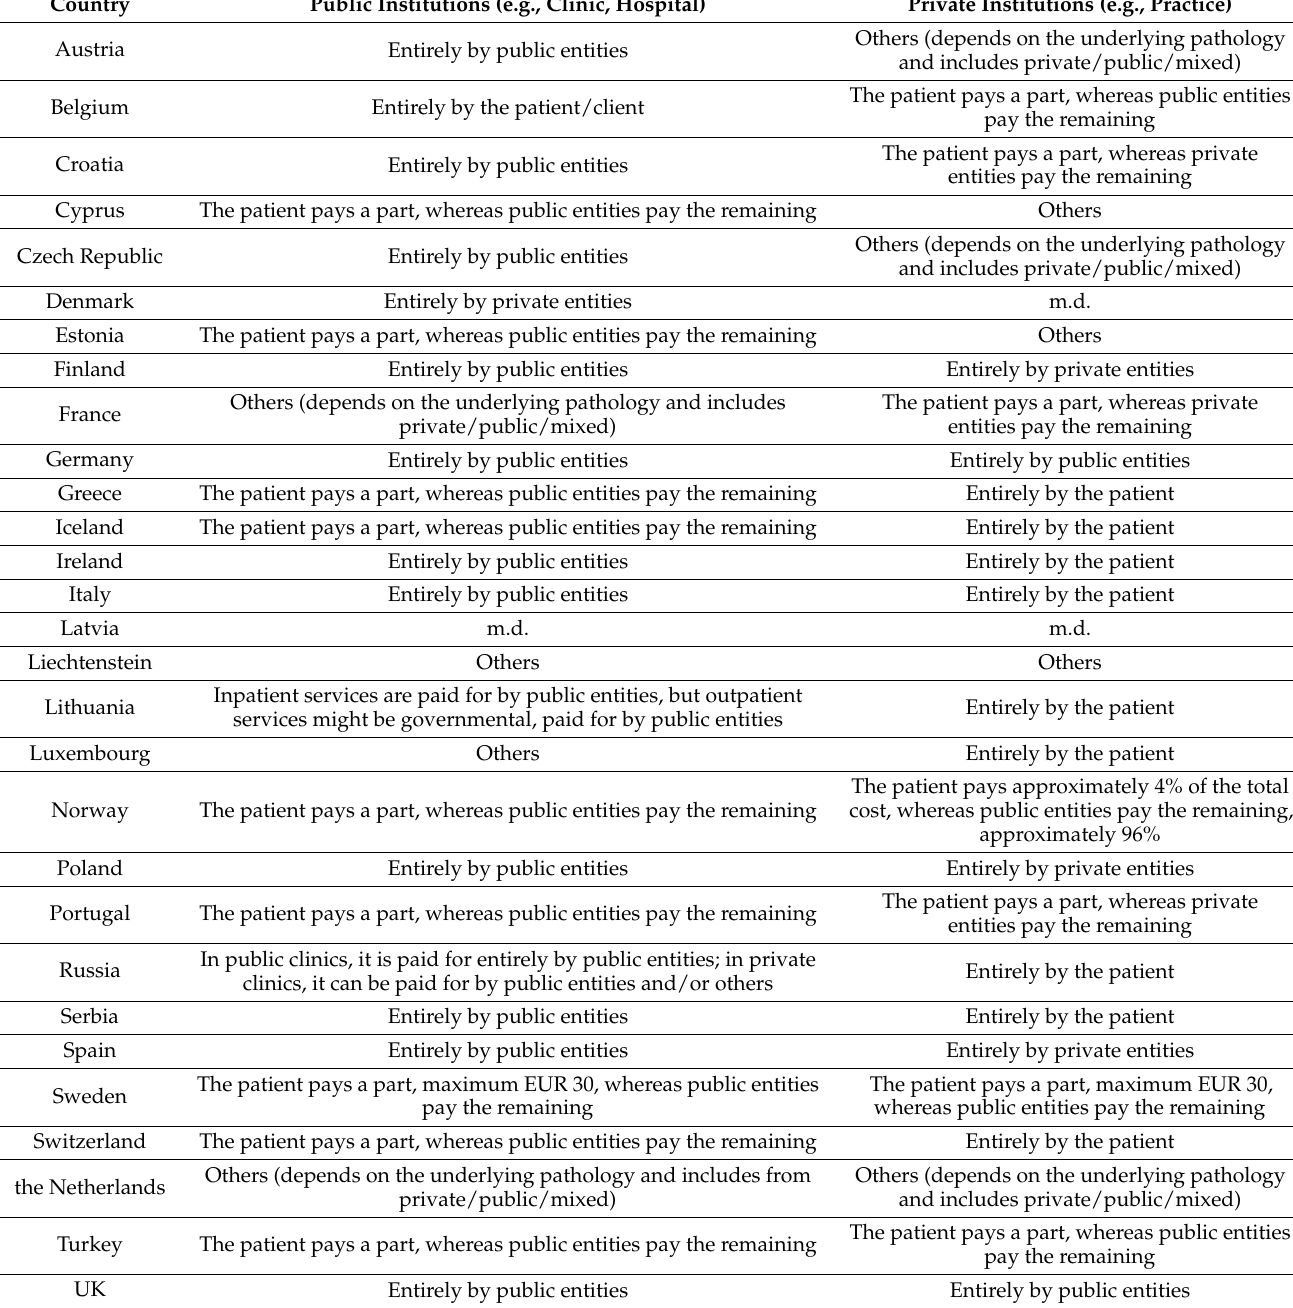
Table 3. Detailed information about payment for clinical